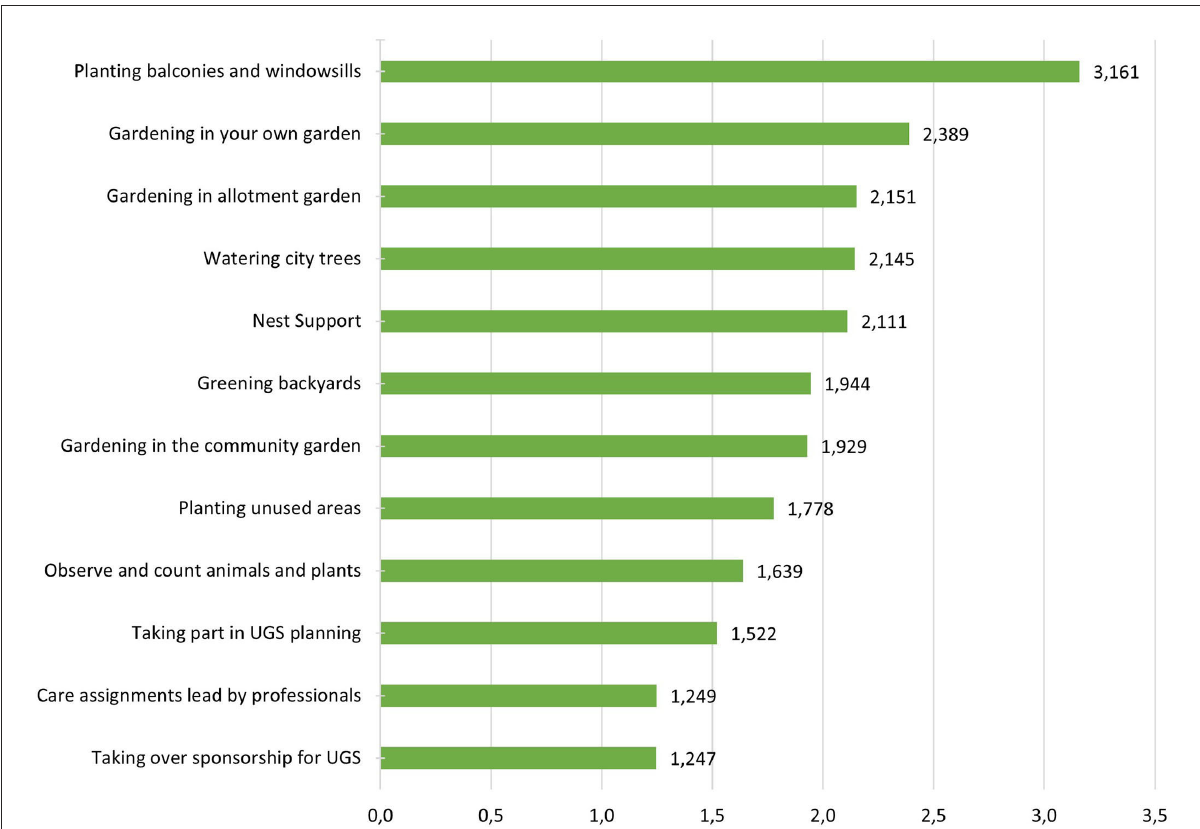
FIGURE5 Mean values of the popularity of participatory actions (mean values range between 0 and 4). Explanation: The X-axis shows the mean values for awareness of and willingness to involve in activities to support Berlin’s urban green. The following applies: 0 = I do not know; 1 = I know but would not like to do; 2 = I do not know but would like to do; 3 = I know and would like to do; 4 = I know and do